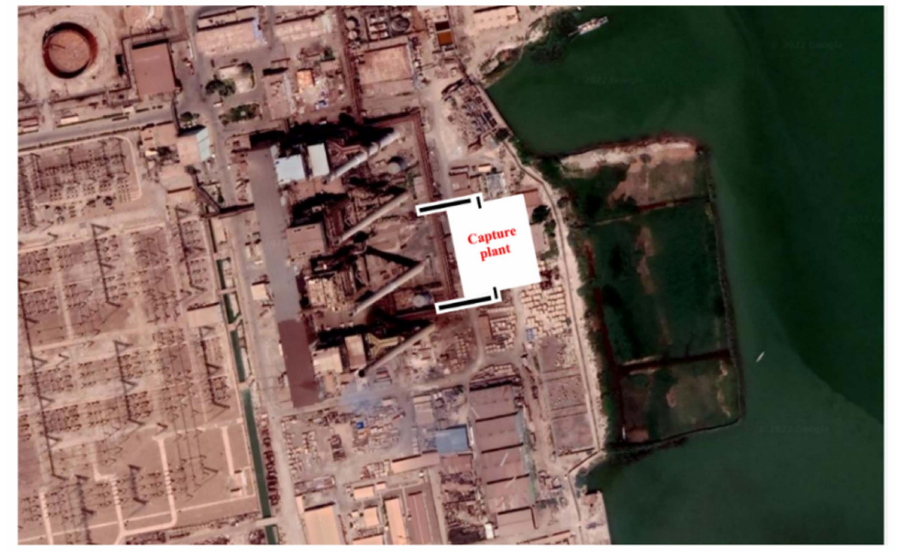
Figure 3. Hartha power plant